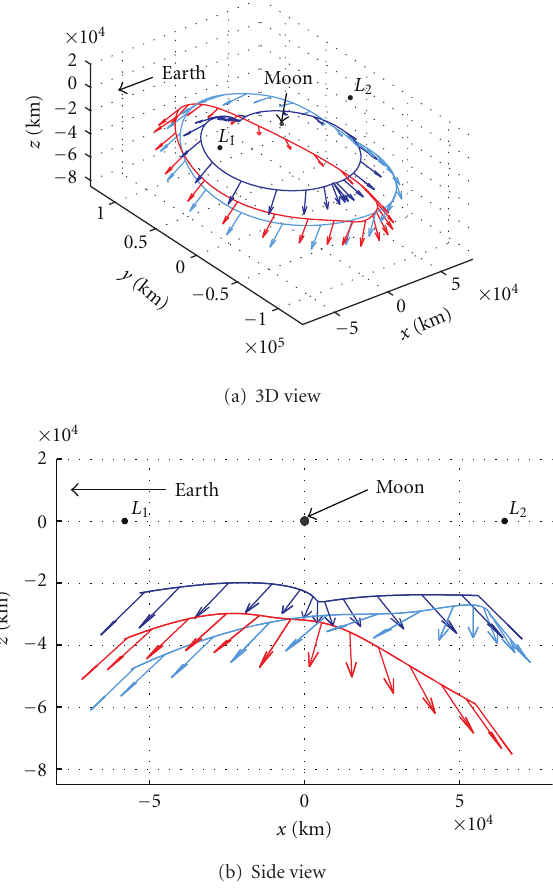
Figure 6: Three converged orbits from the FDM-RV process. Figure 7: Three converged orbits from the Hermite-Simpson collocation